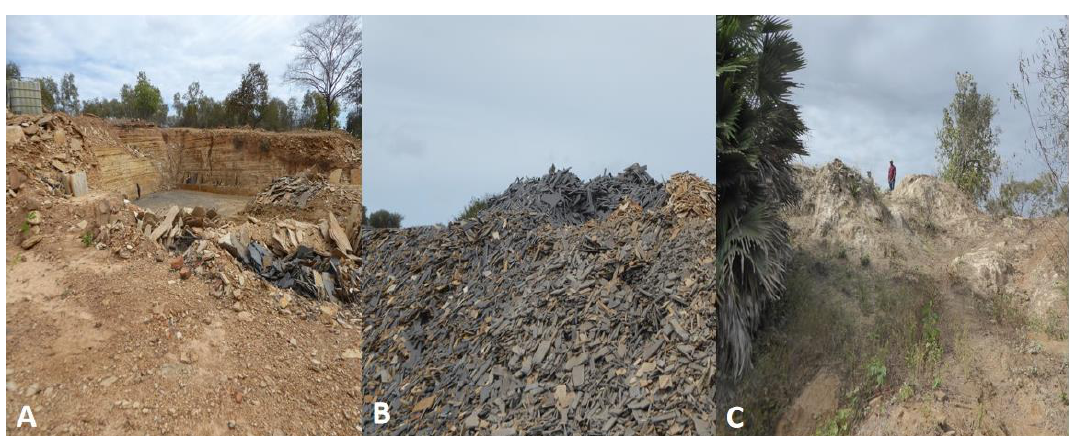
Figure 1. Panoramic view displaying the quarry of stratified quartzite ( A ), tailings ( B ), and tailings in powder form (≅ 29% quartz (Figure S1)) ( C ), resulting from the mining process. Altos, State of Piauí, Brazil.